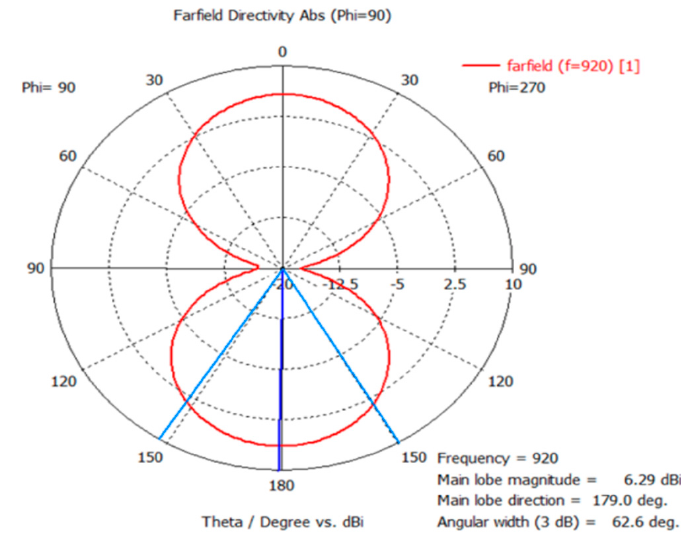
Figure 9. Two-dimensional radiation pattern of the tag antenna at 920 MHz.